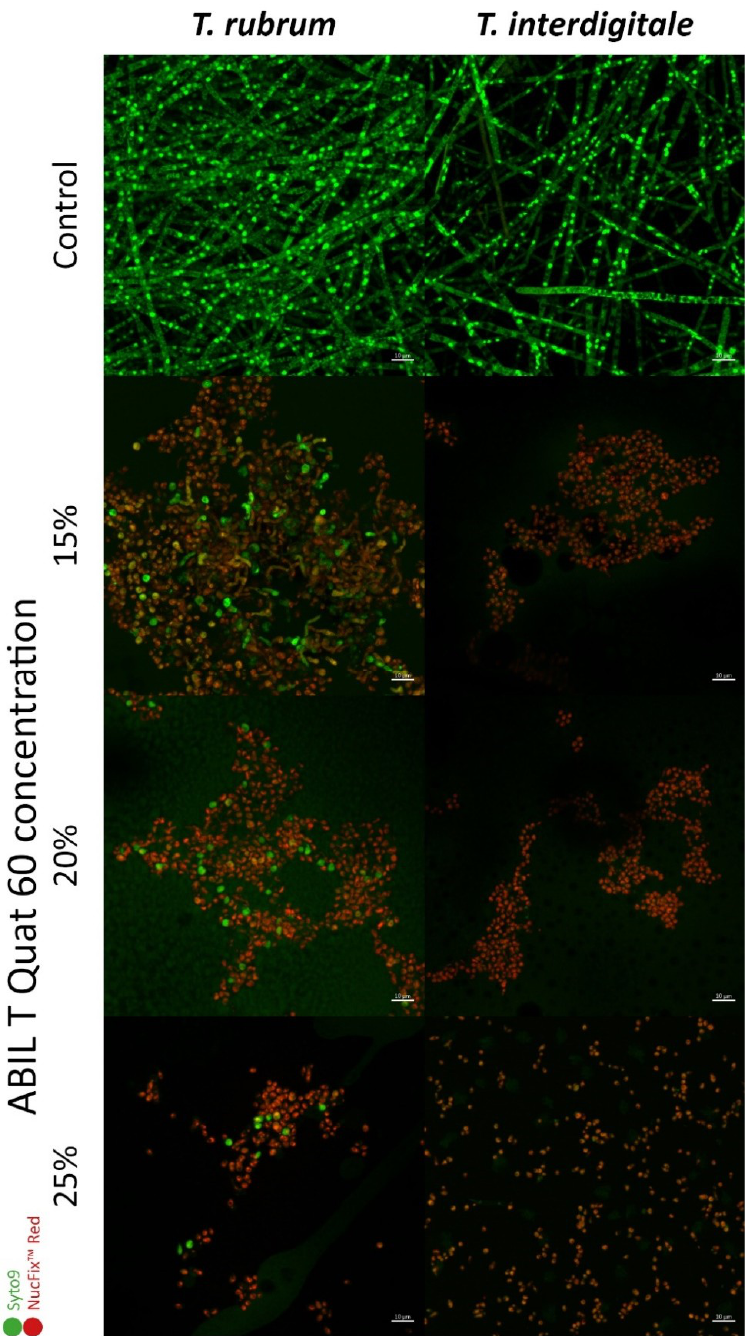
Figure 5. In vitro CLSM images of T. rubrum and T. interdigitale exposed to ABIL (15–25%) and stained with SYTO 9 (green = live) and NucFix™ Red (red = dead). Mycelium developed in the control of both Trichophyton spp., whereas the inoculated conidia did not germinate and were killed by the presence of ABIL.